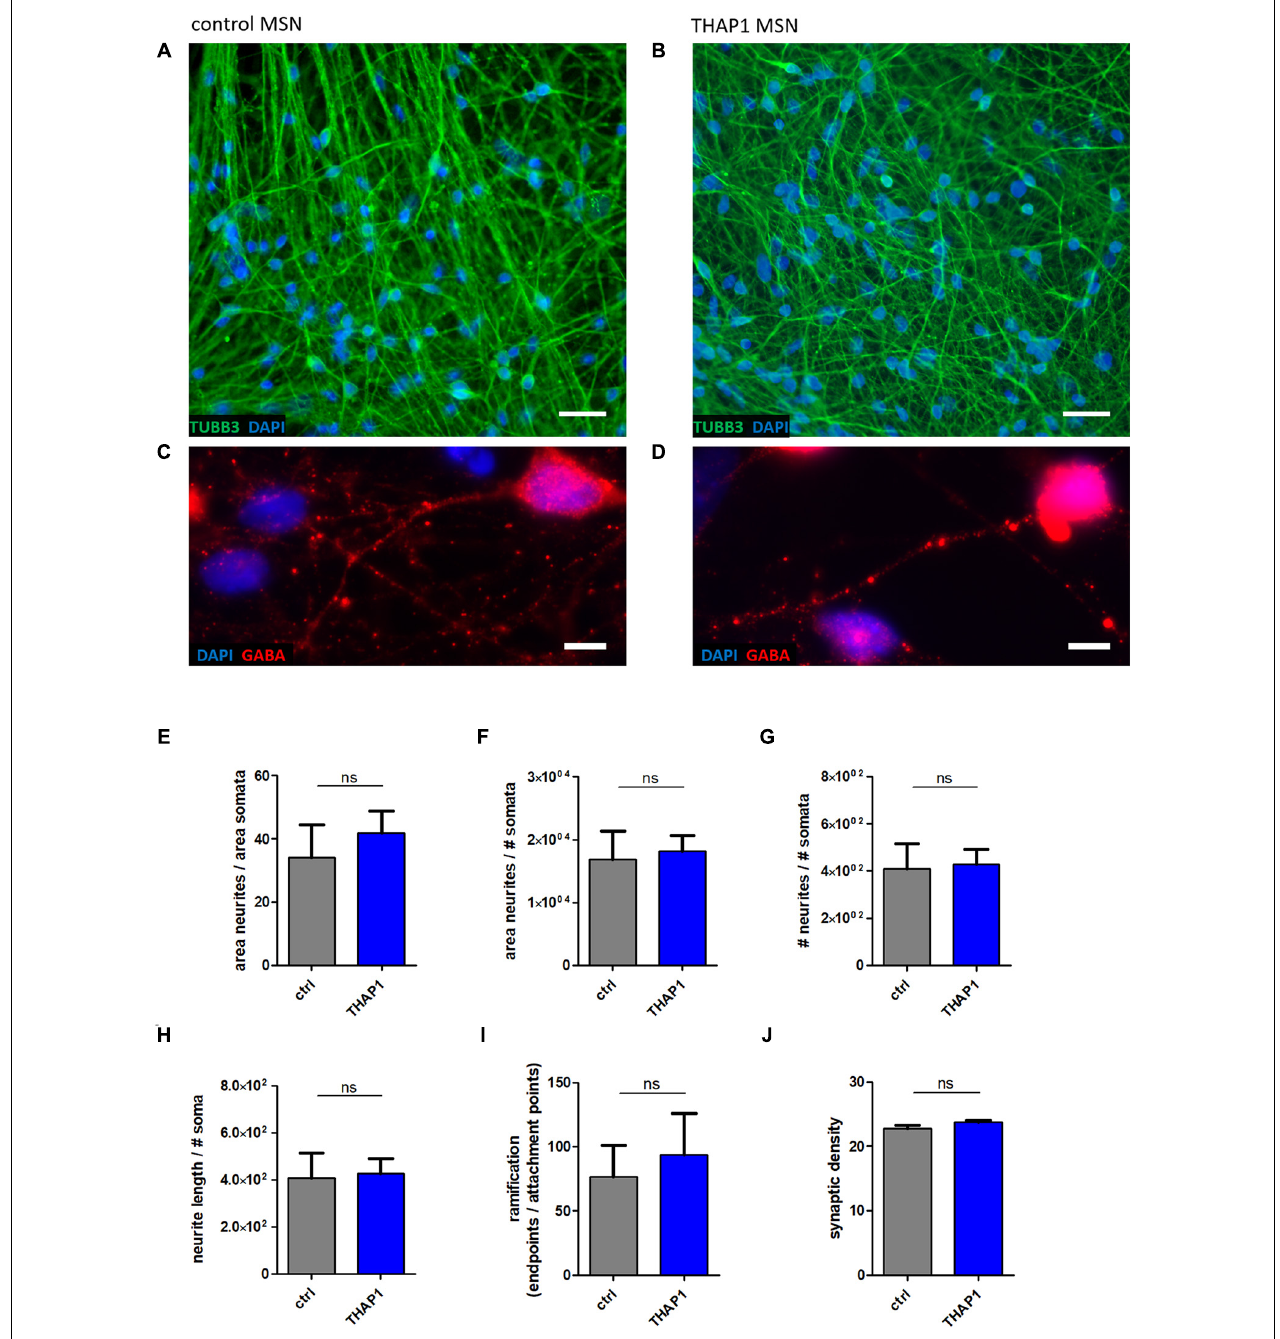
FIGURE 2 | Neuronal morphology and GABAergic synaptic density of MSNs from DYT-THAP1 patients and healthy controls. Control (A,C) and THAP1 MSNs (B,D) were stained for neuronal marker β -tubulin III (TUBB3) and for γ -aminobutyric acid (GABA) to analyze neuronal morphology using ImageJ plugin Neurphology and to quantify GABAergic synapses using ImageJ plugins SynapCountJ and NeuronJ. Nuclei were stained with 4,6-diamidino-2-phenylindole (DAPI). Scale bar indicates 20 µ m (A,B) and 5 µ m (C,D) . Total neurite outgrowth parameters were quantified by normalization of neurites by somata. (E) The area of neurites was divided by the area of somata or (F) the number of somata (# somata). (G) The number of neurites (# neurites) was divided by the number of somata (# somata). (H) Total neurite length was obtained by neurite length divided by # somata. (I) For the evaluation of total ramification, the number of endpoints of neurites was normalized by the number of attachment points at the soma. All of these neurite parameters (E–I) were comparable between THAP1 and control MSNs. (J) No significant difference of THAP1 and control MSNs was detected in regard to the amount of GABAergic synapses. Abbreviation: ns, not significant. Data are presented as means ± SEM from two to three independent differentiations for THAP1 and control lines (non-parametric Mann-Whitney test).